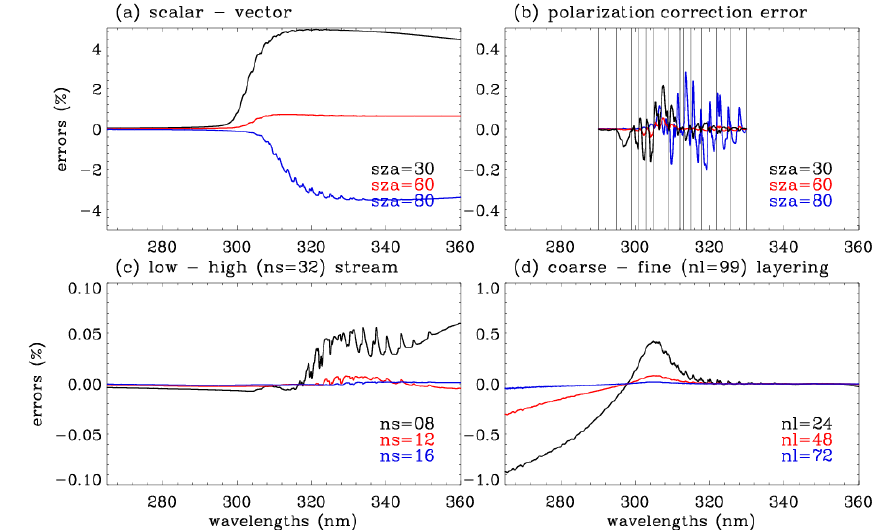
Figure 3. Errors of the radiance simulation due to the RT approximation used in v1, arising from (a) neglecting the polarization effect, (b) polarization correction errors (vertical lines indicate wavelengths at which the vector model is run for deriving the correction spectrum), (c) using a low number of streams (ns), and (d) using a coarse vertical layering (nl = number of layers). Note that this experiment is done at SZA = 65 ◦ , VZA = 30 ◦ , and AZA = 120 ◦ if there is no specific